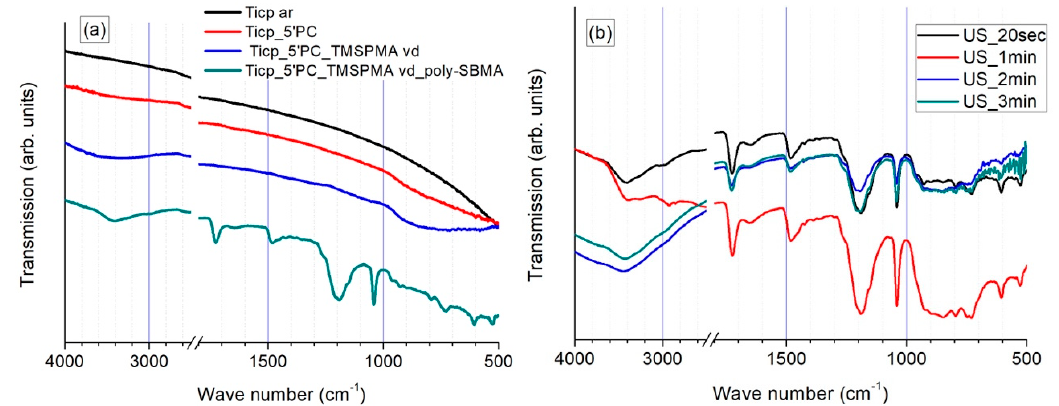
Figure 1. ( a ) ATR-FTIR spectra from differently treated TiCP samples. ( a , b ) PolySBMA coating after cumulative ultrasonic treatment from 20 s to 3 min (US). TiCp ar: as-received titanium substrate; TiCP 5’PC: after 5 min of oxygen plasma treatment; TiCP 5’PC_TMSPMA vd: vapor deposited TMSPMA primer; TiCP 5’PC_TMSPMA vd_polySBMA: photopolymerized SBMA. Table 2. FTIR band assignment of different TiCP sample treatments. Ti Specimen